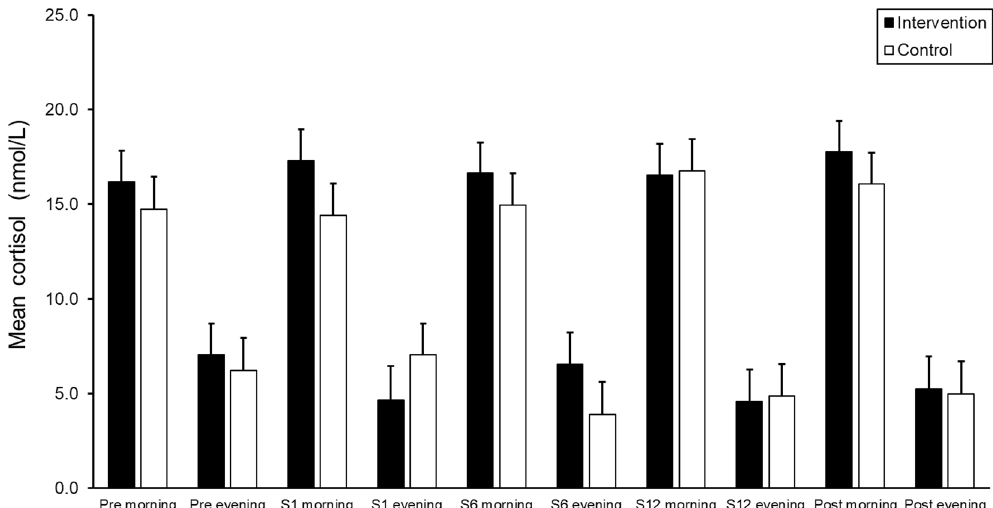
Figure 2. Salivary cortisol level in the morning and evening at pre intervention; sessions (s) 1, 6, and 12; and post-intervention, for the intervention and control conditions. Error bars represent 1 standard error.